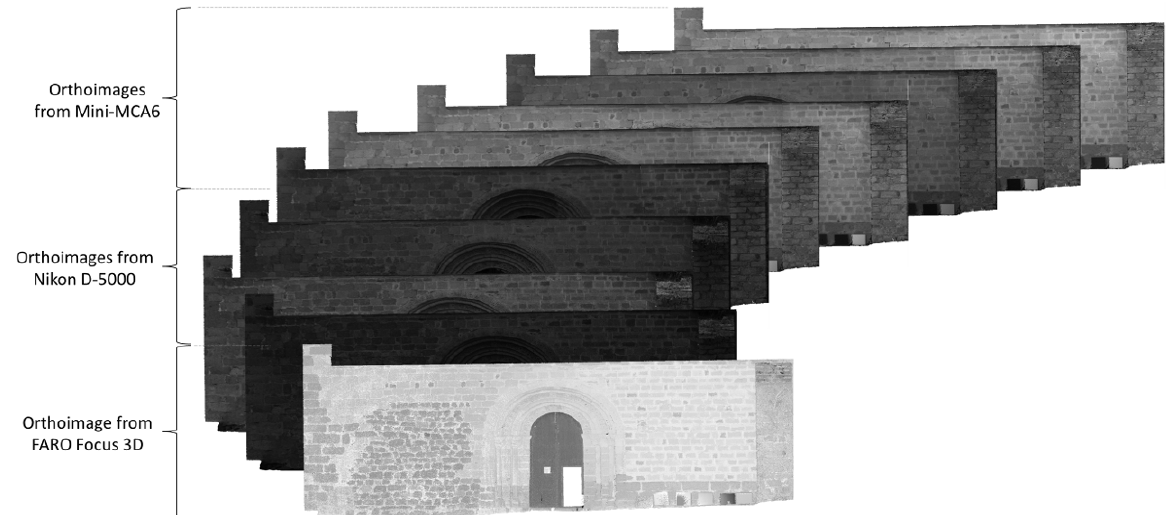
Figure 4. Orthoimages of the southern façade from the 3 analysed